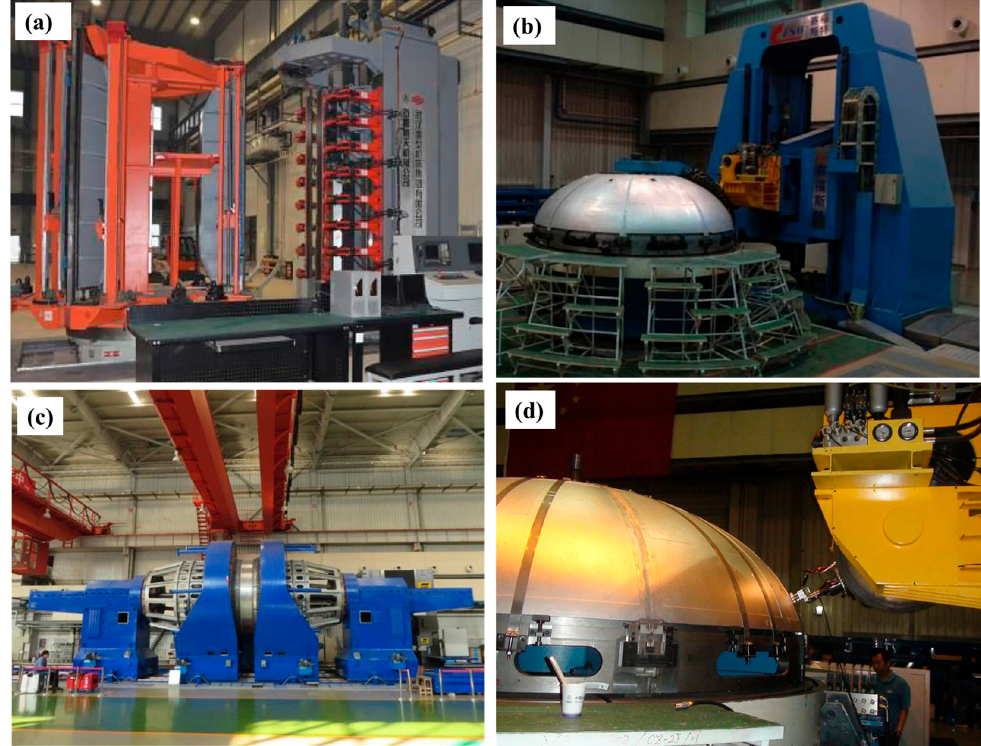
Figure 19. Fuel tank FSW machines. ( a ) Longitudinal FSW equipment of tank section, ( b ) FSW equipment of tank dome, ( c ) circumferential FSW equipment for tank, and ( d ) automatic online PAUT for tank welding with non-planar path [45] (has permission from Elsevier).